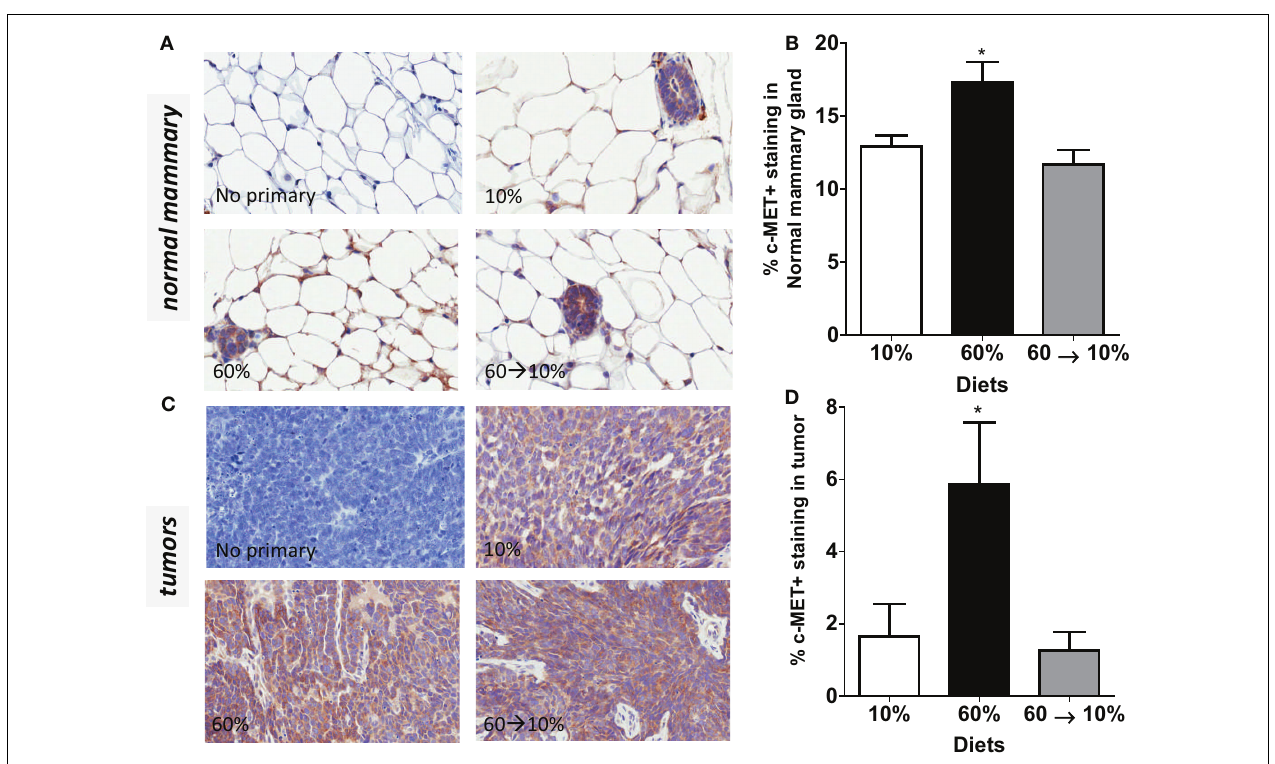
[* 10% ( P = 0.043) and 60 → 10% ( P = 0.019) vs. 60%]. Staining was quantified in normal mammary glands and tumors in n = 2 sections from five mice using Aperio Imagescope software and the membrane IHC algorithm for c-Met